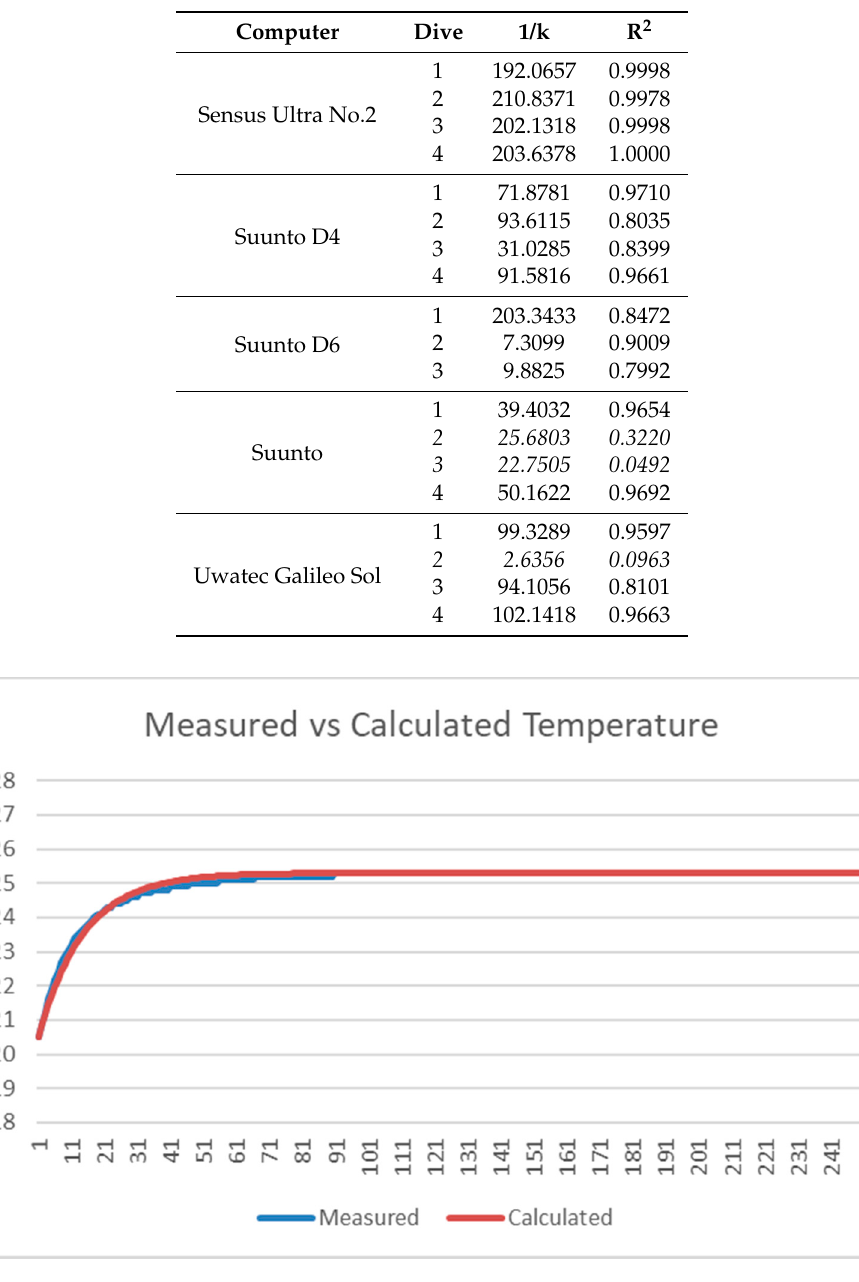
Figure 7. Sample curve fit for the dive computer Mares Smart. The resulting time constant is 66.06 s with an R 2 of 0.9877.